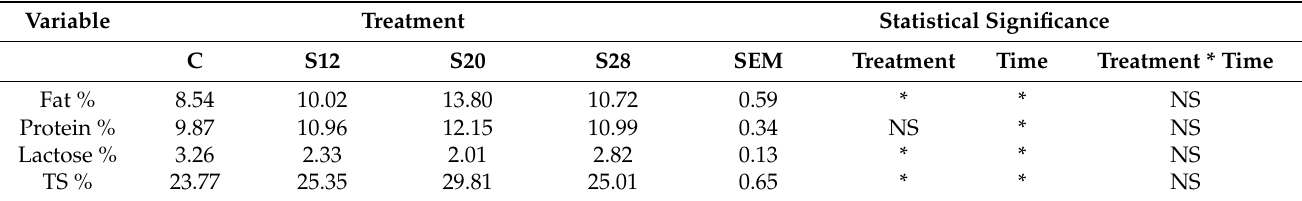
Table 2. The effect of different levels of sunflower hulls on the colostrum composition (%). Variable